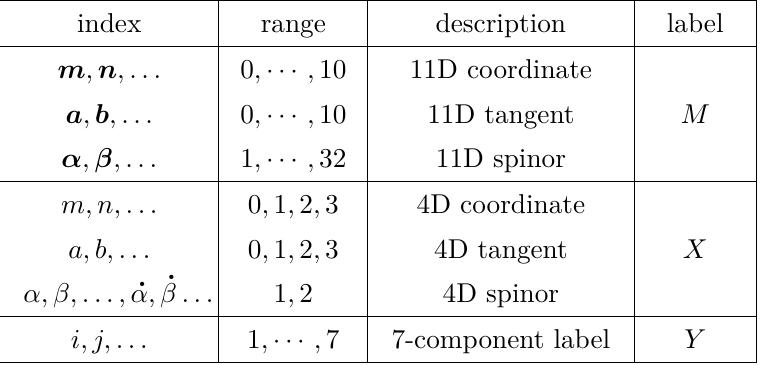
representation, and 2